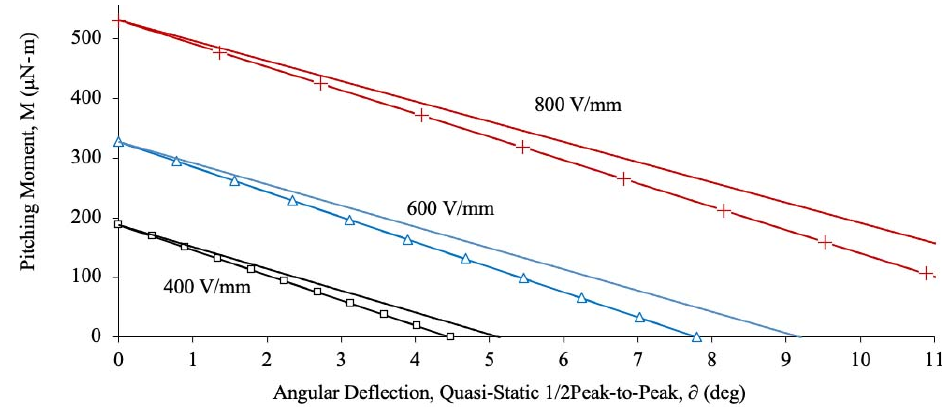
Figure 14. Quasi-Static Moment-Deflection Results.